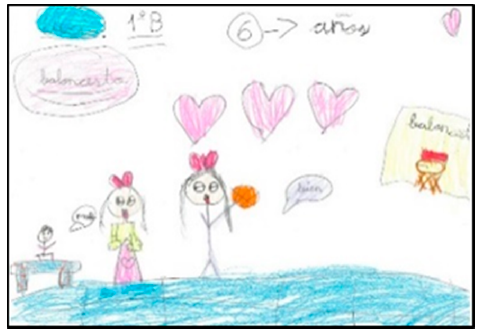
Figure 6. Represented space. Lucía. 1°B.